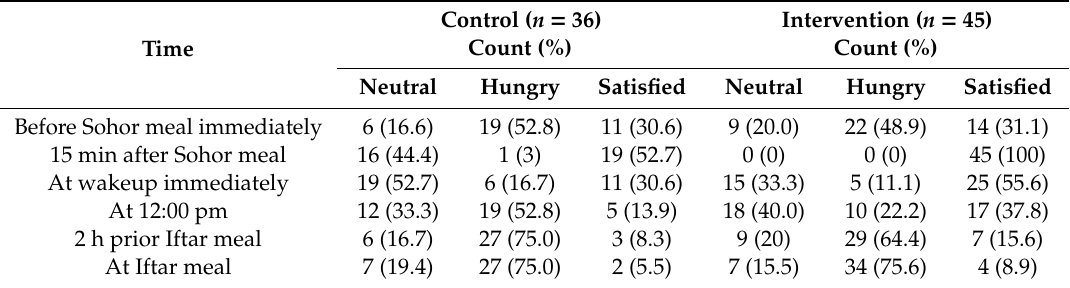
Table 3. Satiety scale at the endpoint of Ramadan for control and intervention